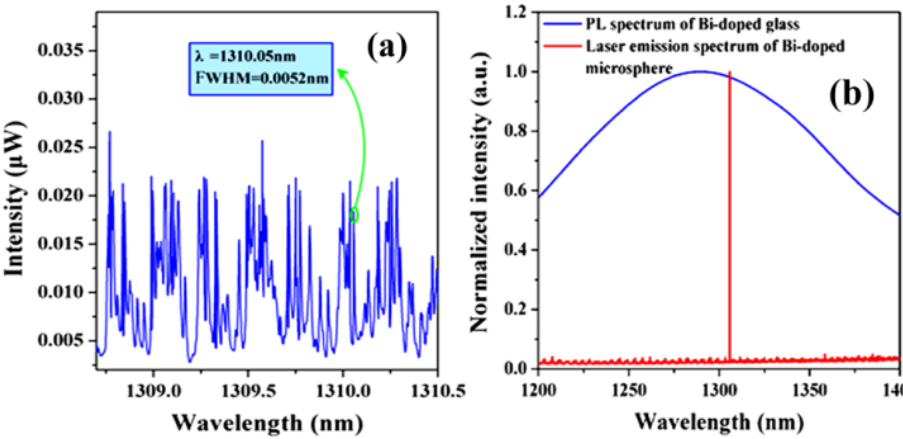
Figure 11. ( a ) Spectrum of the WGMs when the pump light is coupled into the microsphere; ( b ) red line: spectrum of the Bi ‐ doped microsphere laser output; blue line: fluorescence spectrum of the Bi ‐ doped glass. Reprinted/Adapted with permission from [37].